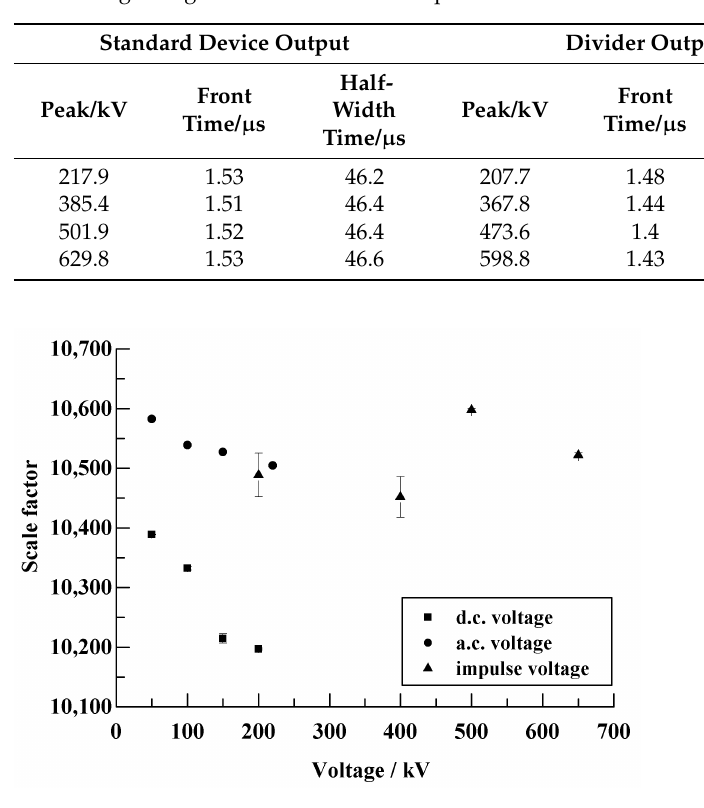
Table 4. Lightning test results at room temperature.